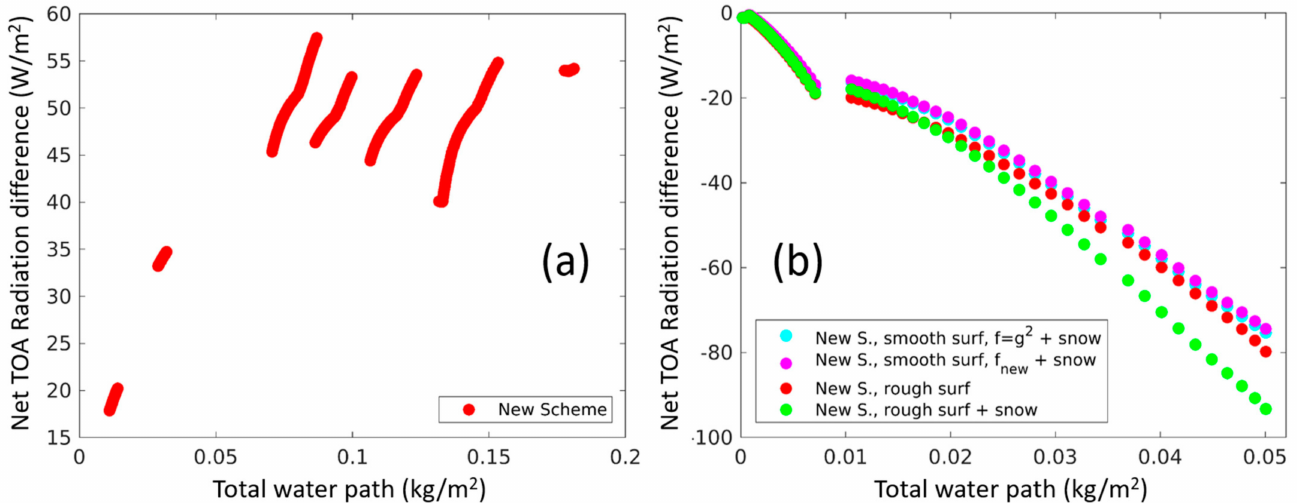
Figure 8. ( a ) Net (incoming minus outgoing) top-of-atmosphere (TOA) radiation difference between the new scheme and RG92, versus liquid water path for 7 experiments of warm stratus. Positive values indicate the warming effect of the new scheme with respect to RG92. ( b ) Net top-of-atmosphere radiation difference between the 4 versions of the new scheme and RG92, versus liquid water path for 3 experiments of cirrus (color details are in the capture of Figure 7a). Negative values indicate the cooling effect of the new scheme with respect to